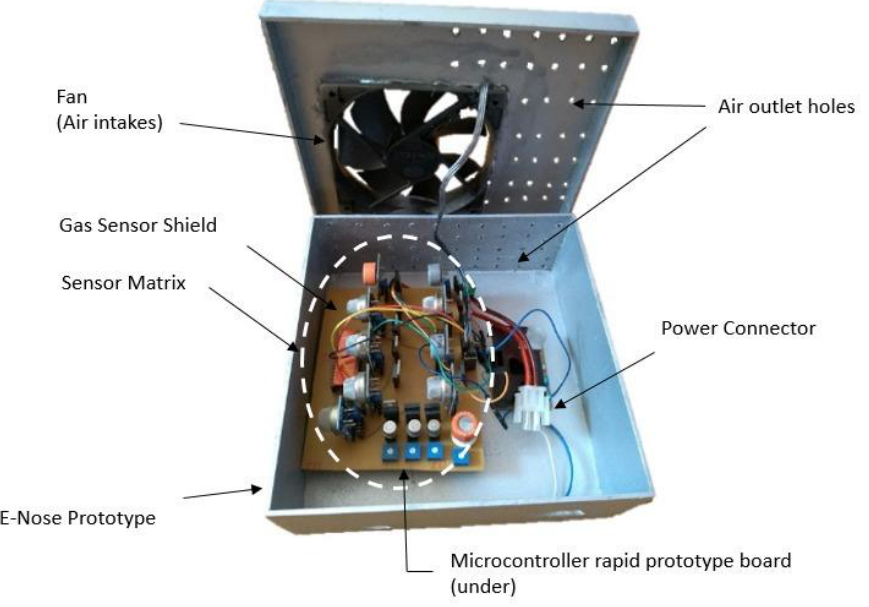
Figure 2. Equipment developed.